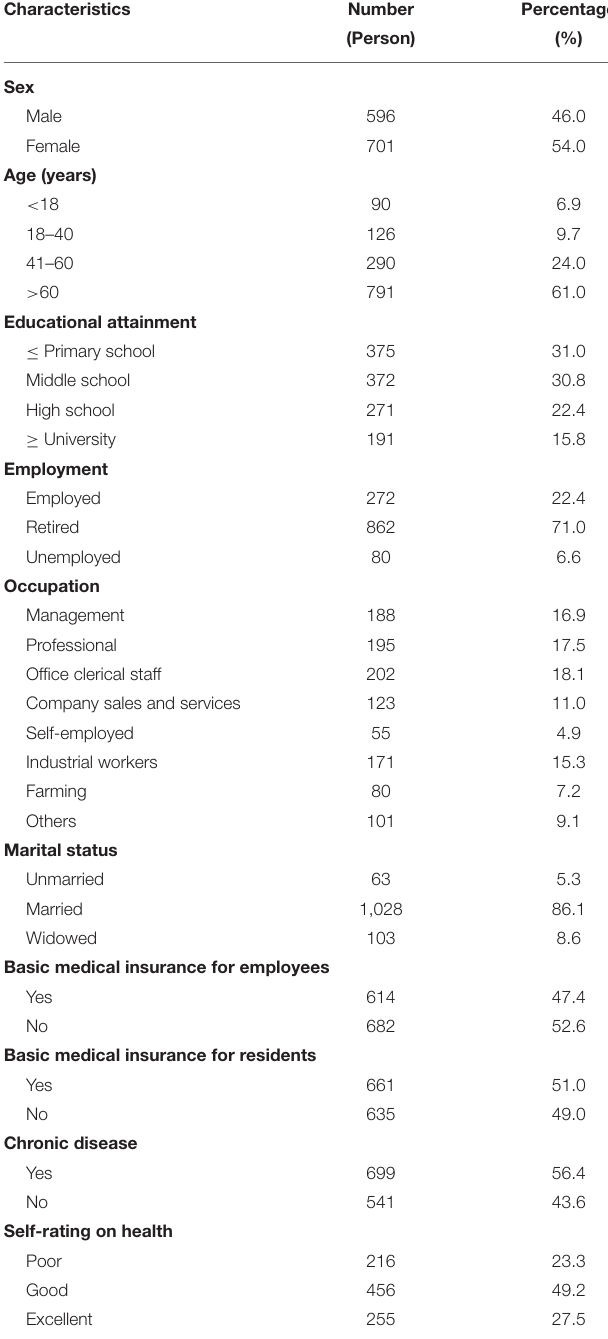
TABLE 1 | Characteristics of study